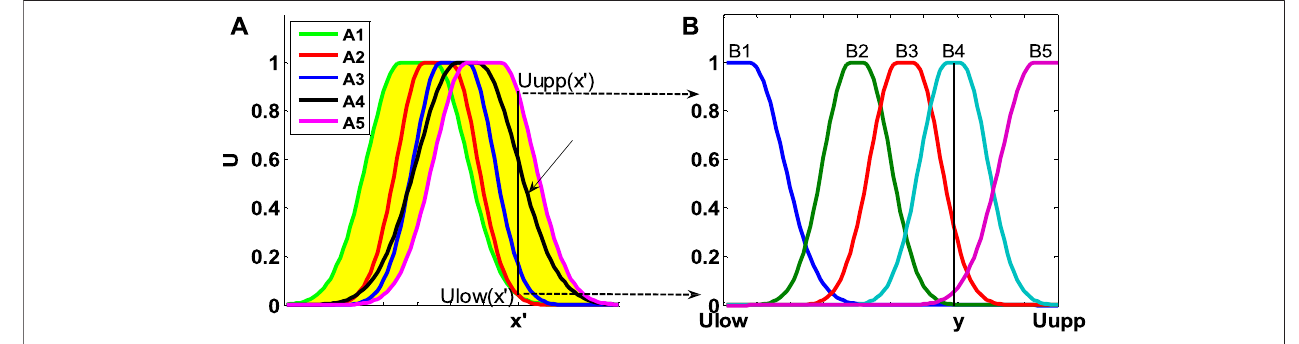
FIGURE 4 | Secondary-uncertainty – varying membership functions (A) and further illustration (B) .